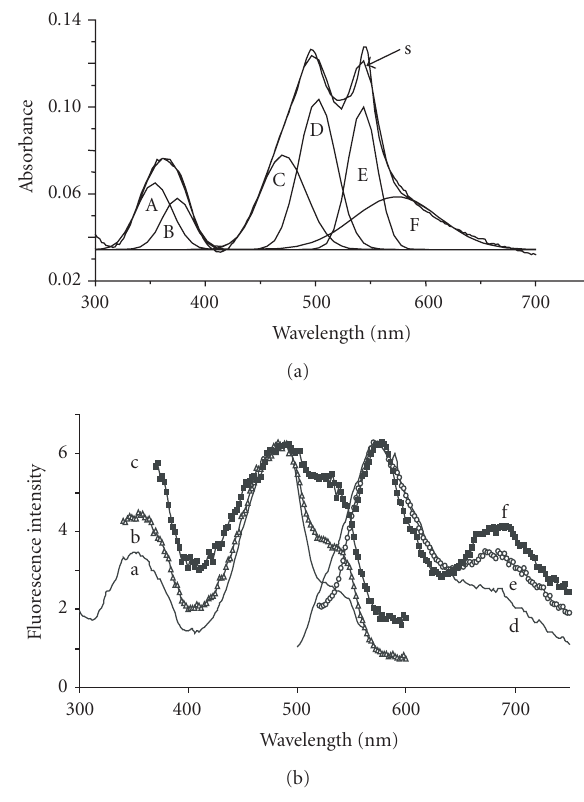
Figure 3: Top: UV/vis absorption spectrum of microcrystals of 1 grown in the presence of poly(acrylic acid, sodium salt) (5 . 9 × 10 − 4 M). Bands A to F were obtained by deconvolution, using six Gaussian functions. Spectrum s is the sum of the calculated bands. Bottom: Excitation spectrum (left) for di ff erent emission wave- lengths (a) 570nm, (b) 660nm and (c) 720nm; Emission spectrum (right) for di ff erent excitation wavelengths (d) 482nm, (e) 510 and (f) 545nm. Total dye concentration in the suspension: 2 × 10 − 5